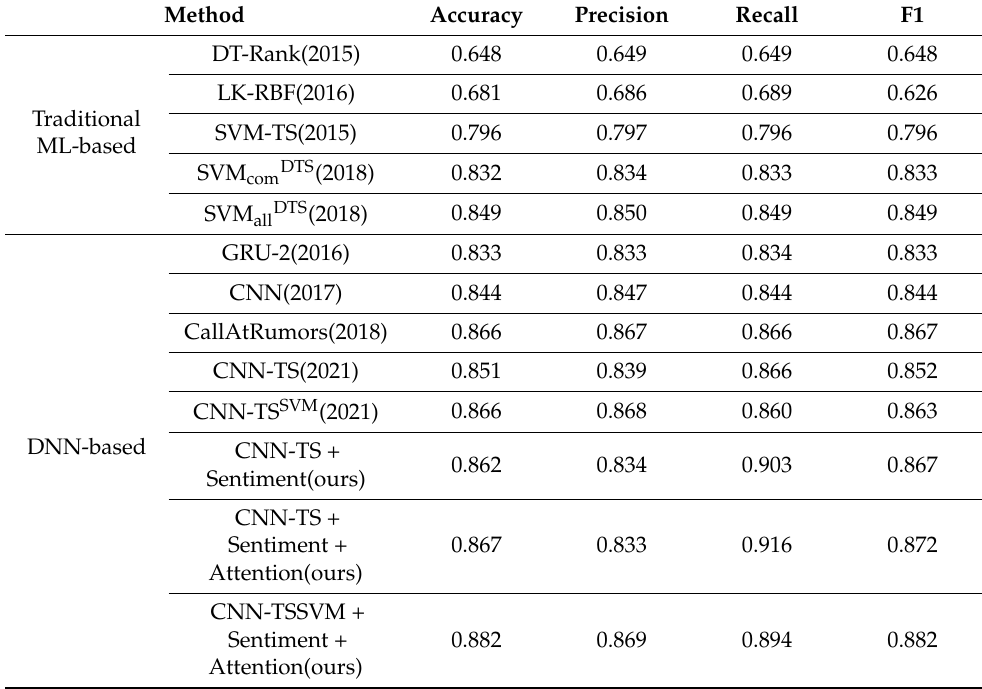
Table 4. Performance of rumor event detection methods on Sina